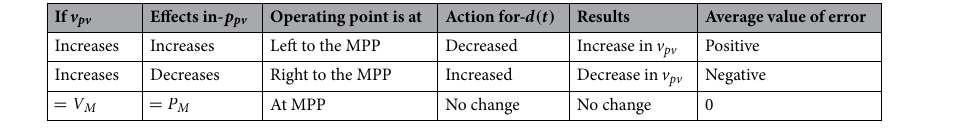
Table 1. Summary of RCC control laws, (7) and